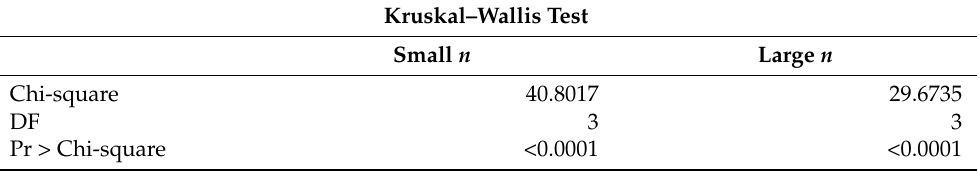
Table 5. Kruskal–Wallis Test.